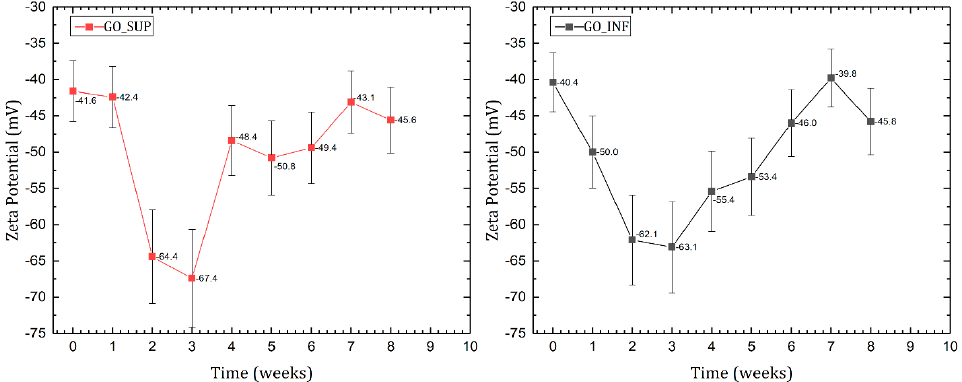
Figure 4. ζ − potential variation for GO suspension fractions GO_SUP ( right ) and GO_INF ( left ) over the course of 8 weeks after the synthesis process.